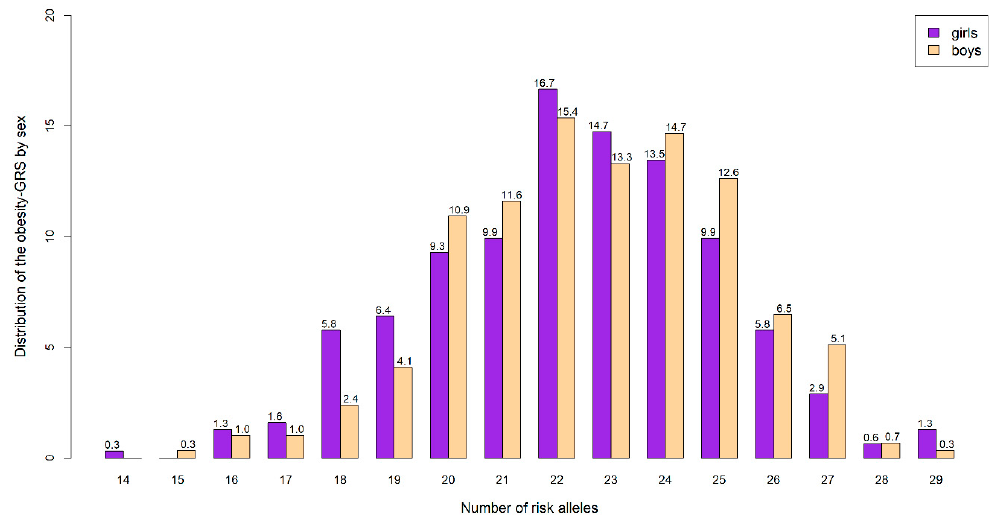
Figure 2. Distribution of the obesity-GRS (obesity-related genetic risk score) by sex (% displayed) in the HELENA cohort according to the number of risk alleles.